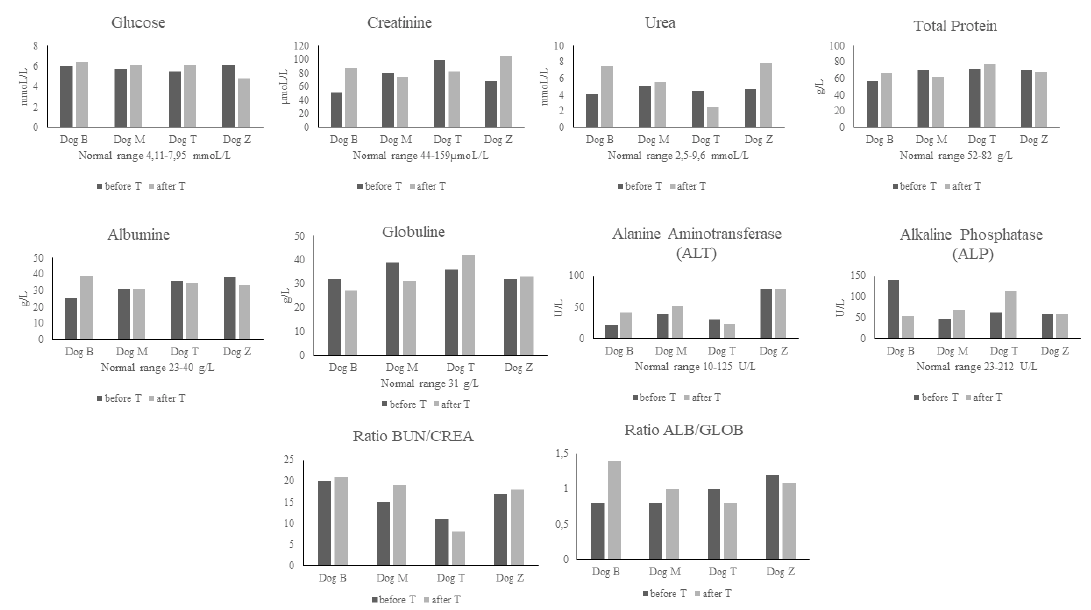
Figure 4. Biochemistry parameters before treatment (before T) and after treatment (after T), blood urea nitrogen (BUN), creatinine (CREA), ALB (albumin), GLOB (globulin). Table 2. Hematology parameters before treatment (BT) and after treatment (AT), RBC (red blood cells), HCT (hematocrit), HGB (hemoglobin), MCV (mean corpuscular volume), MCH (mean corpuscular hemoglobin), MCHC (mean corpuscular hemoglobin concentration), RDW (red cell distribution width), RETIC (reticulocytes), WBC (white blood cells), NEU (neutrophils), LYM (lymphocytes), MONO (monocytes), EOS (eosinophils), BASO (basophiles), PLT (platelets), MPV (mean platelet volume), PDW (platelet distribution width), PCT (plateletcrit).